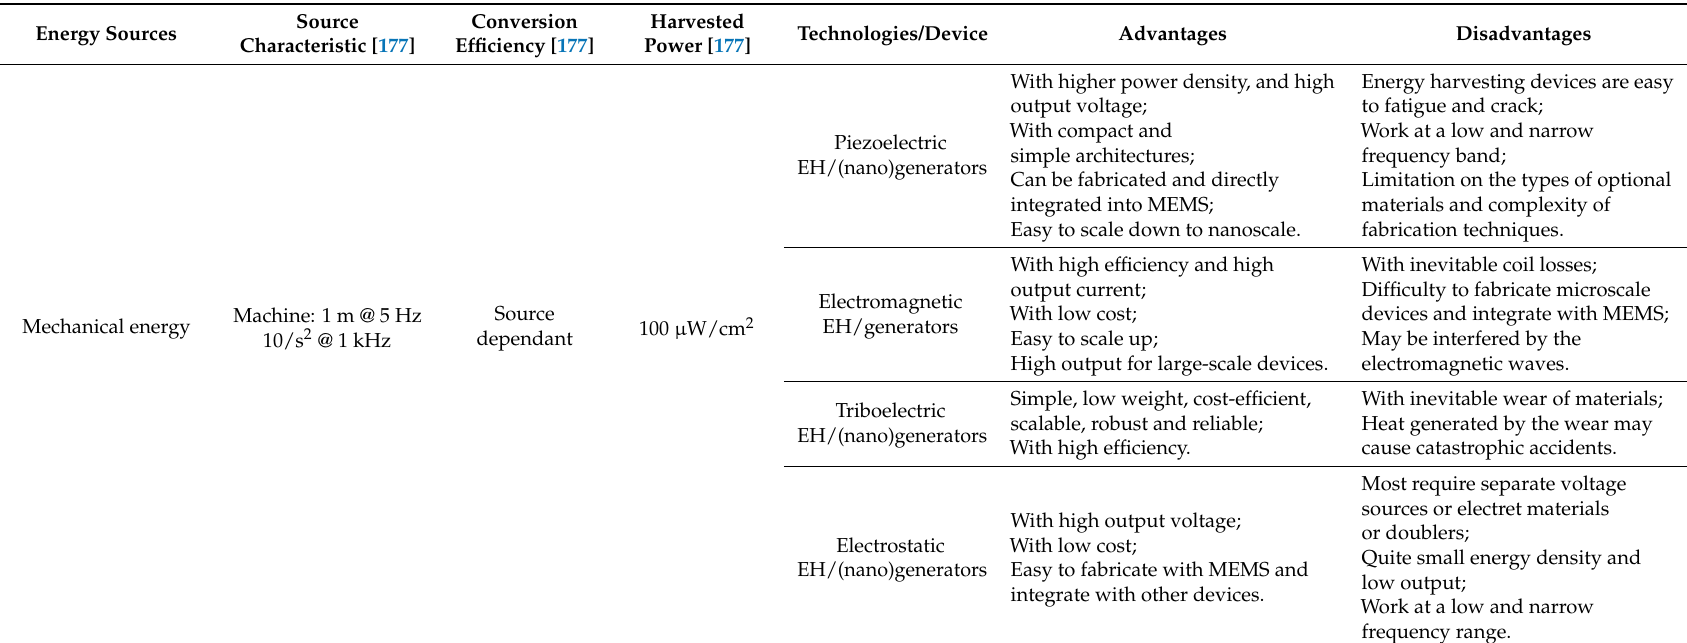
Table 7. Comparison of various energy harvesting